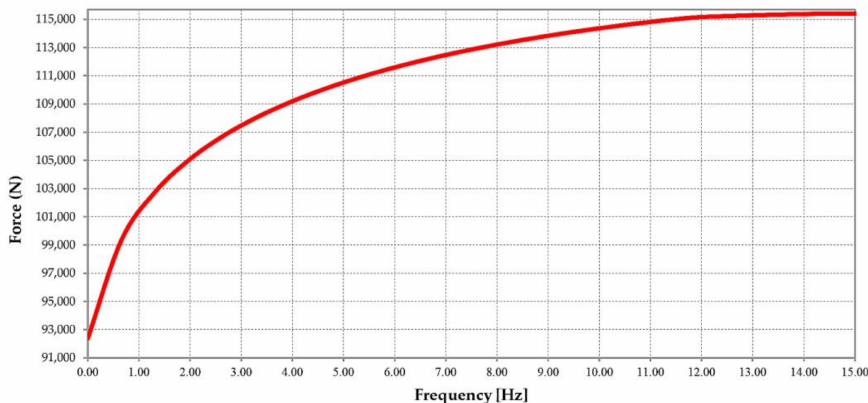
Figure 9. Variation of force vs.